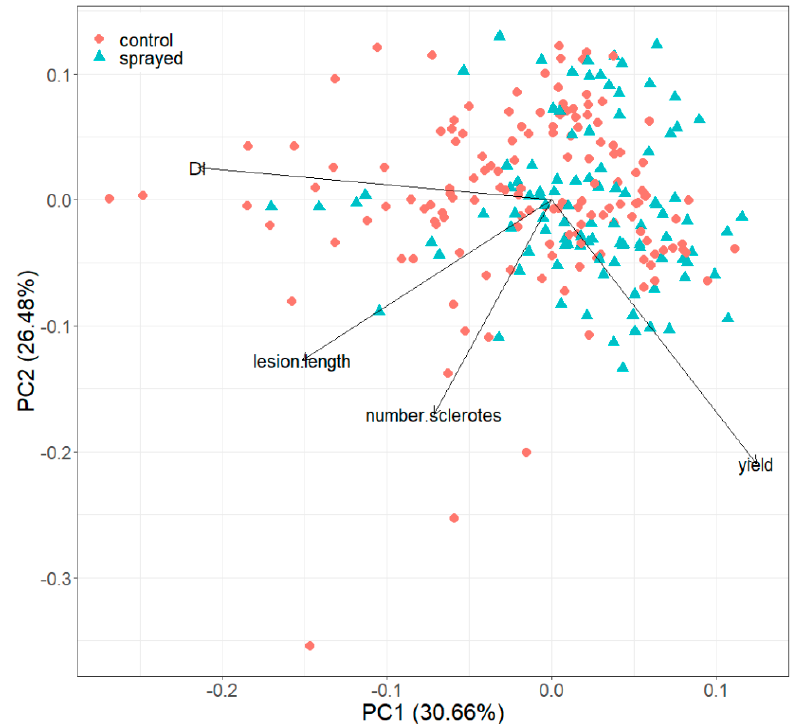
Figure 6. Principal Components Analysis (PCA) biplot of 246 diseased plots from 16 sites across four growing seasons (2017–2020). Two management treatments were applied: no fungicide (control) and fungicide at 30% flowering (sprayed).